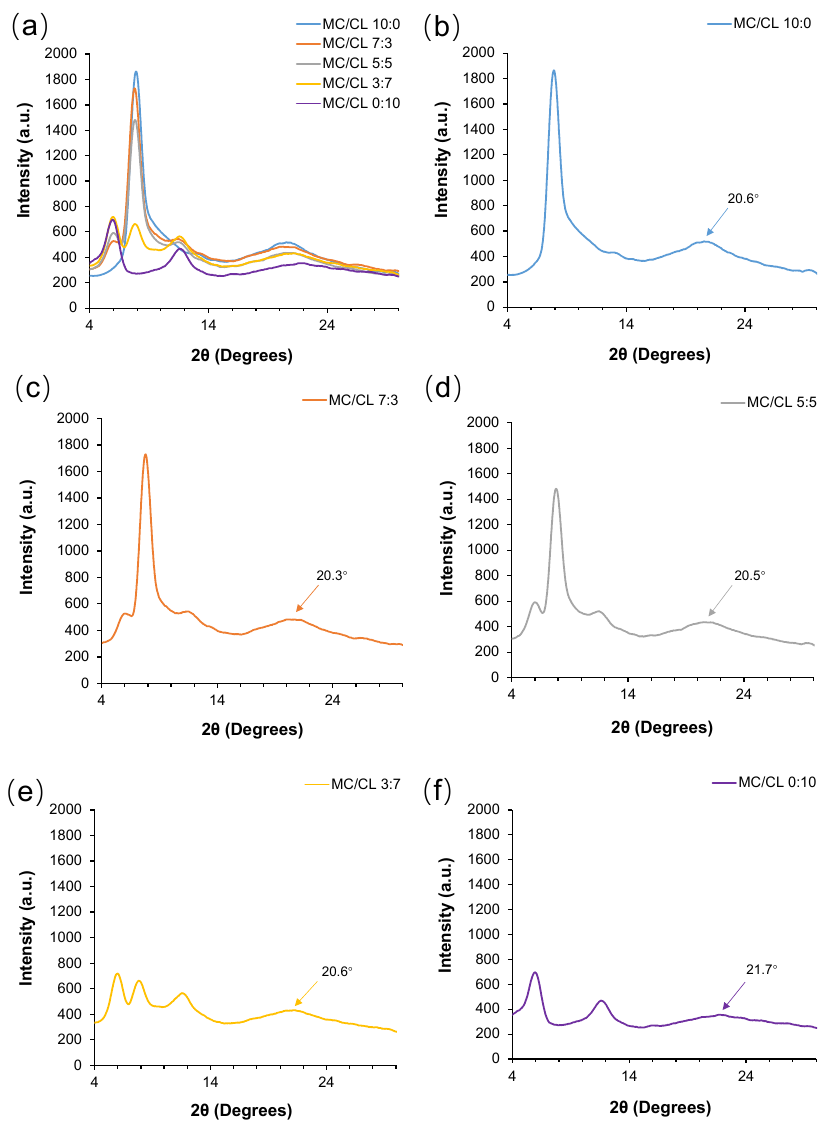
Figure 3. XRD spectra of MC/CL films with different blend ratios: ( a ) all the films displayed in one figure; ( b ) MC/CL 10:0; ( c ) MC/CL 7:3; ( d ) MC/CL 5:5; ( e ) MC/CL 3:7; ( f ) MC/CL 0:10.